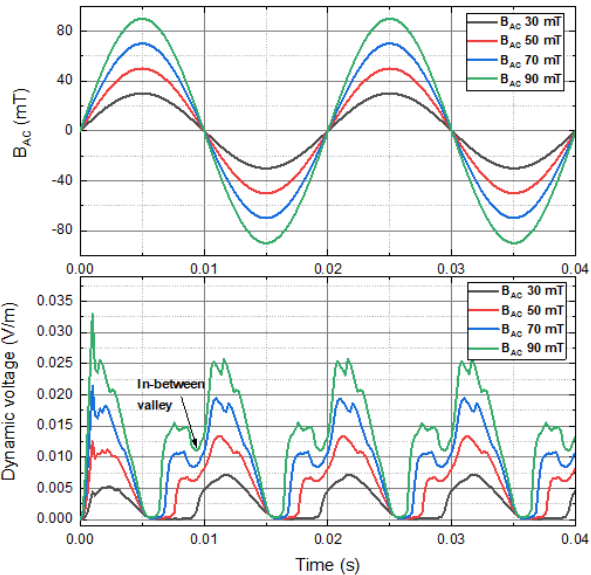
Figure 6. Instantaneous dynamic voltage of a 4 mm HTS tape, carrying a 30 A DC transport current and in the presence of the perpendicular sinusoidal AC magnetic field at 50 Hz, with the peak magnitude 30 mT, 50 mT, 70 mT and 90 mT.